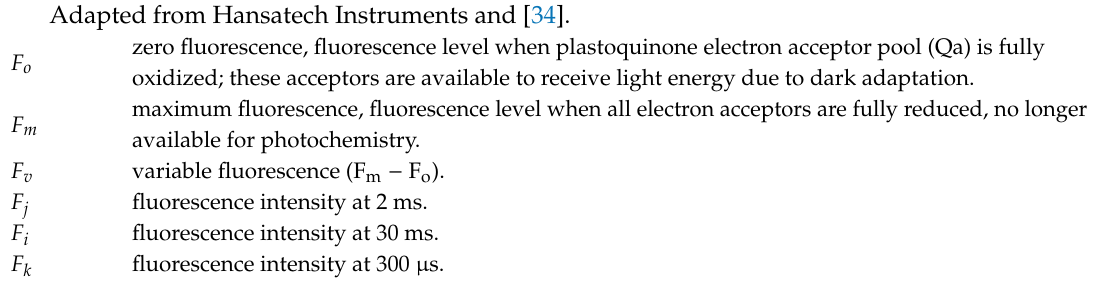
Table S1: Means and standard deviations of fluorescence indexes for all PGRs concentrations in experiment; Figure S2: Boxplots of fluorescence indexes; Figure S3: Photograph of the experiment; Figure S4: Average month temperatures, precipitation and light period in Ú st í nad Labem in